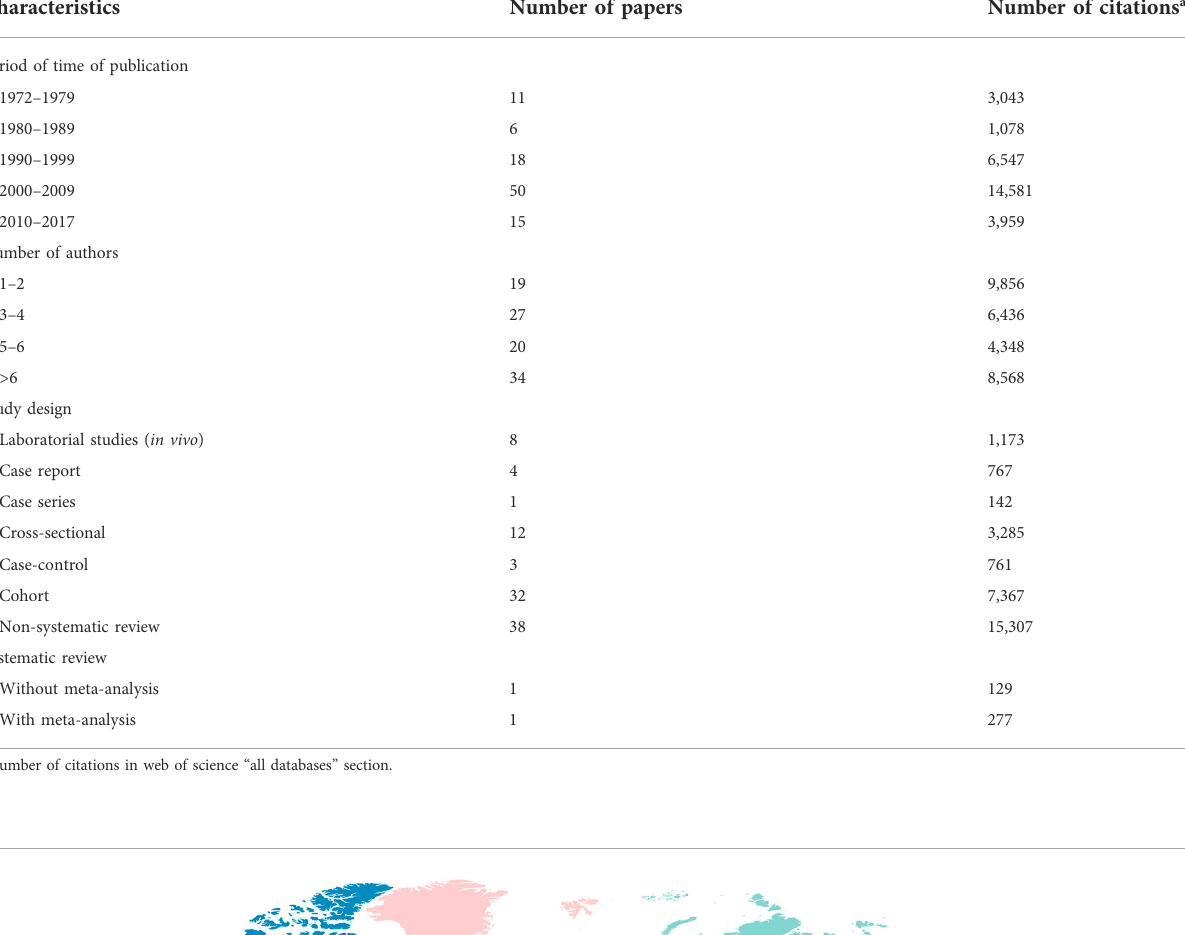
TABLE 1 Frequencies of characteristics of the 100 most-cited papers in maternal exposure to methylmercury and offspring health outcomes. Characteristics